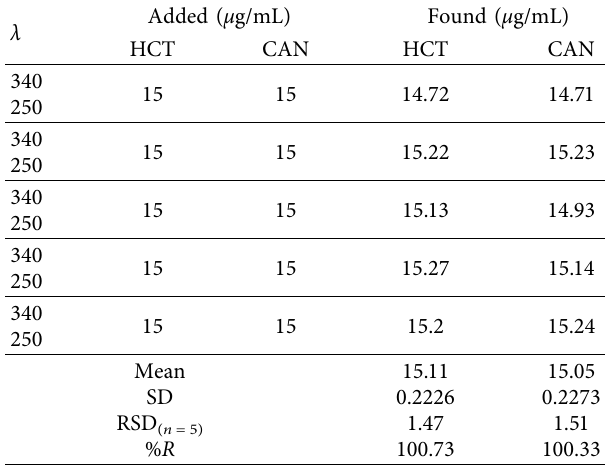
Table 11: Precision of the Q -absorption ratio method in the de- termination of HCT and CAN.